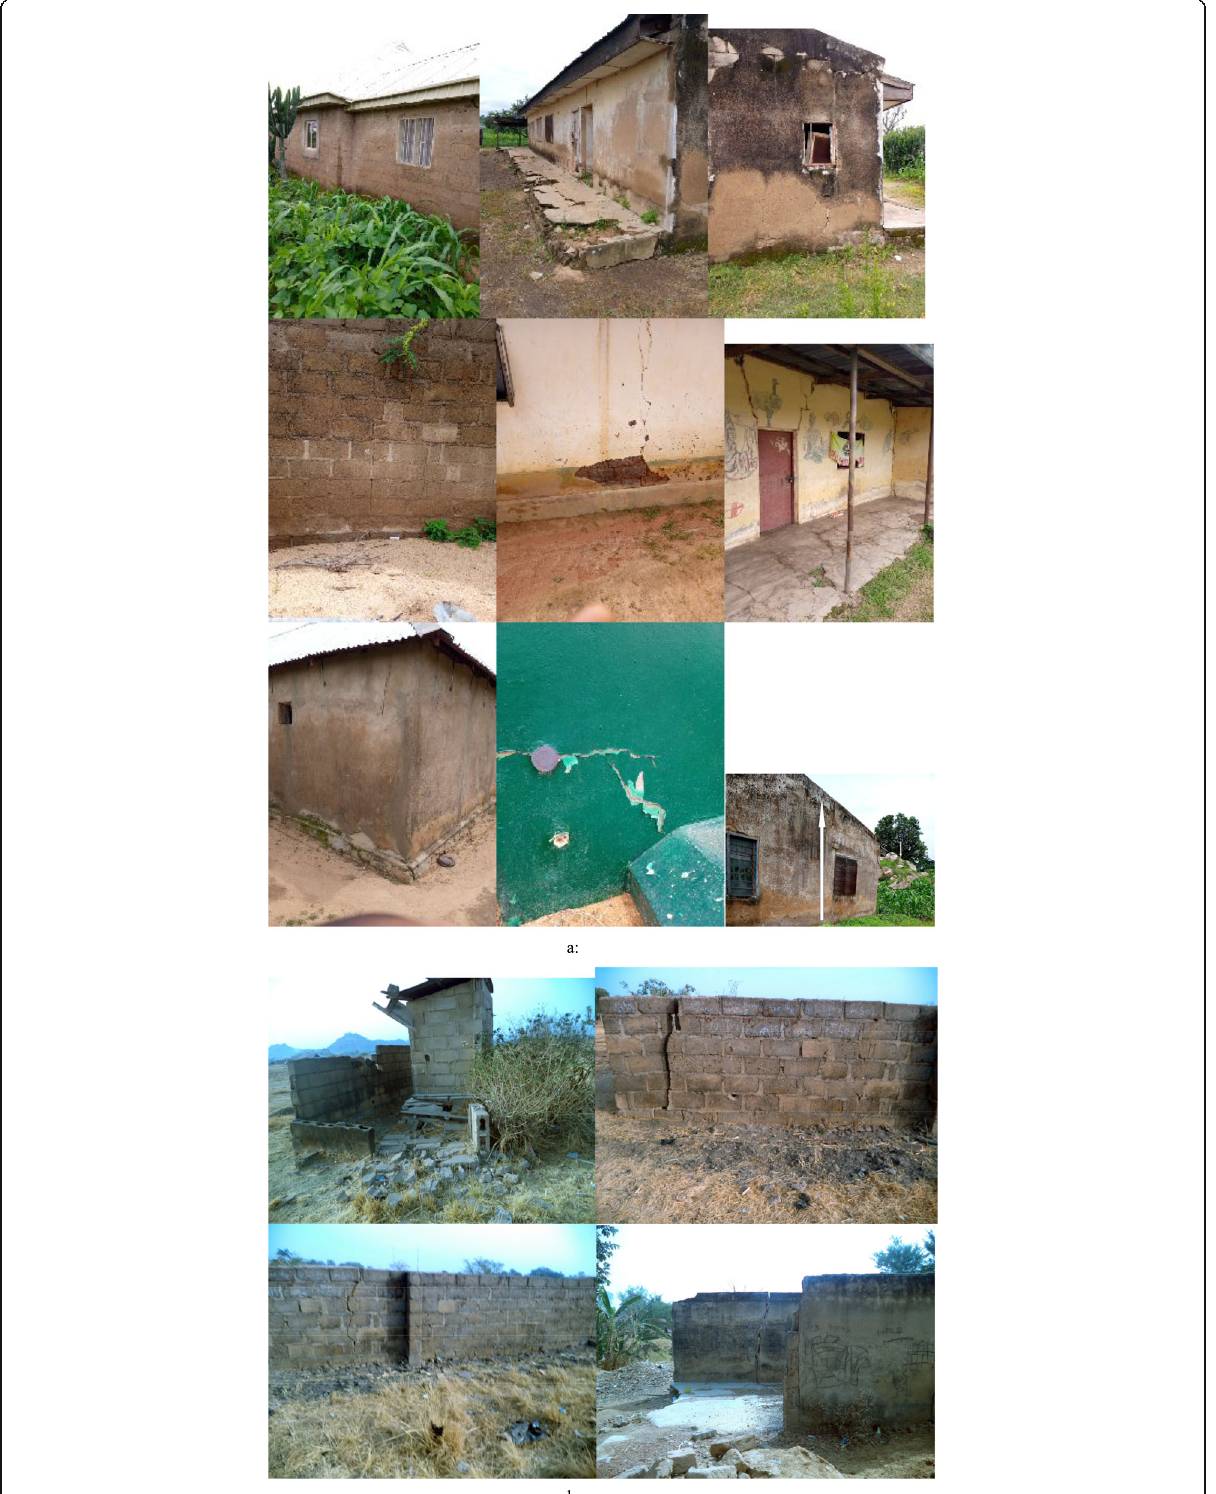
Fig. 6 a Photographs showing the nature of infrastructural collapse on cohesionless soils in the study area. b Photographs showing the nature of infrastructural collapse on cohesive soils in the study